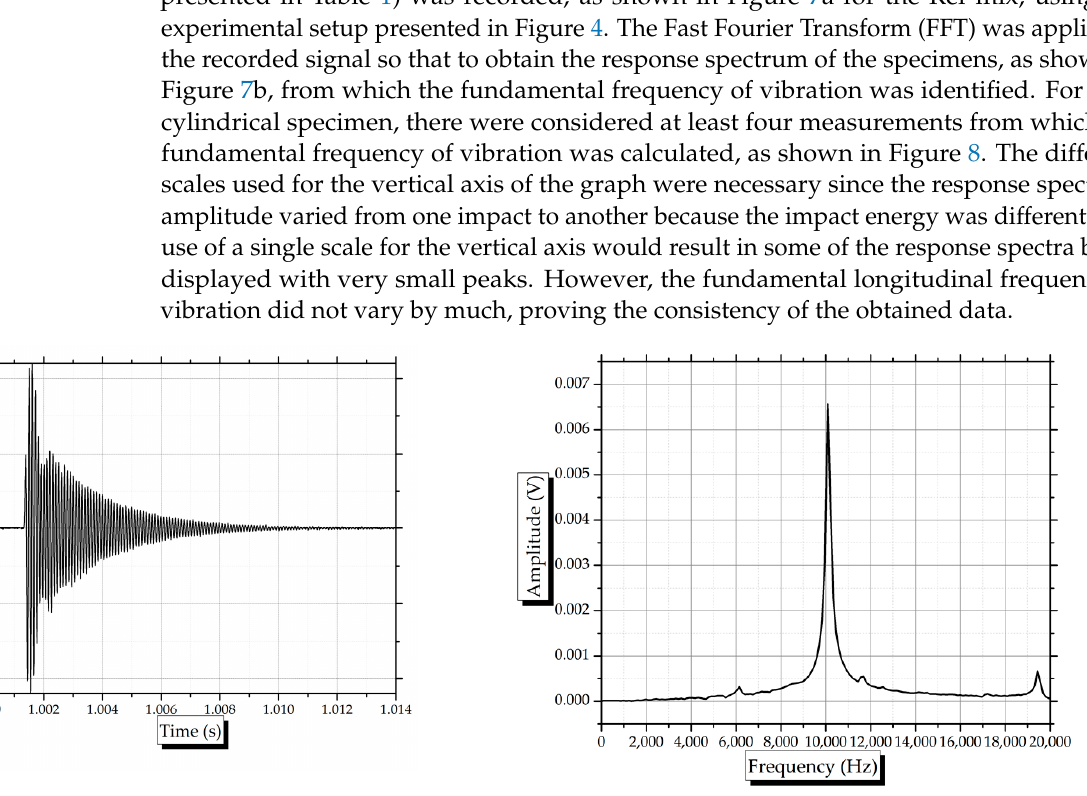
Figure 7. Assessment of the fundamental frequency of vibration. ( a ) Damped free vibrations; ( b ) Response spectrum (FFT).